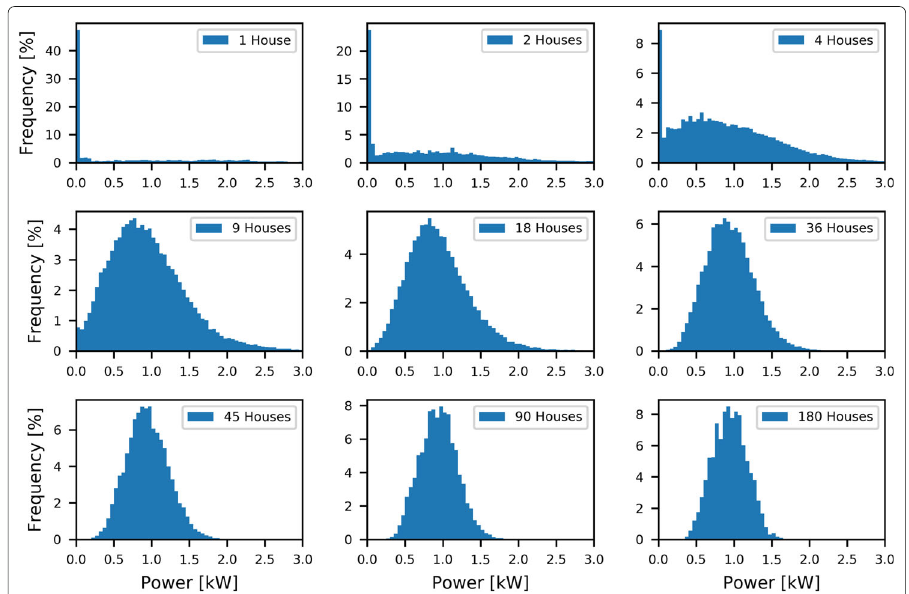
Fig. 7 Distributions (bins of 50 W) of the average space heating and hot water power consumption (over 15 minutes) of 180 households grouped in pools of different sizes in January 2020. All histograms were cut at a maximal power of 3 kW to facilitate the comparison. However, for really small pools, it results in part of the distribution not